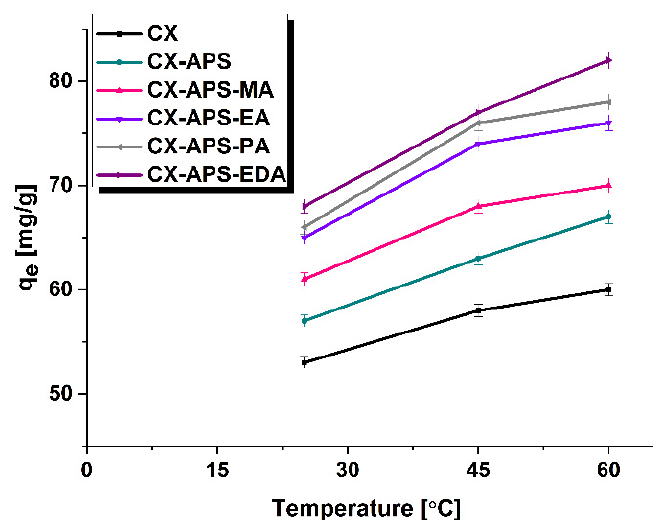
Figure 8. The influence of temperature on the adsorption of thymol blue (adsorbent mass, 20 mg; initial dye solution concentration, 80 mg/L; volume of dye solution, 50 mL; pH = 4; temperature, 25, 45, and 60 ± 1 °C).